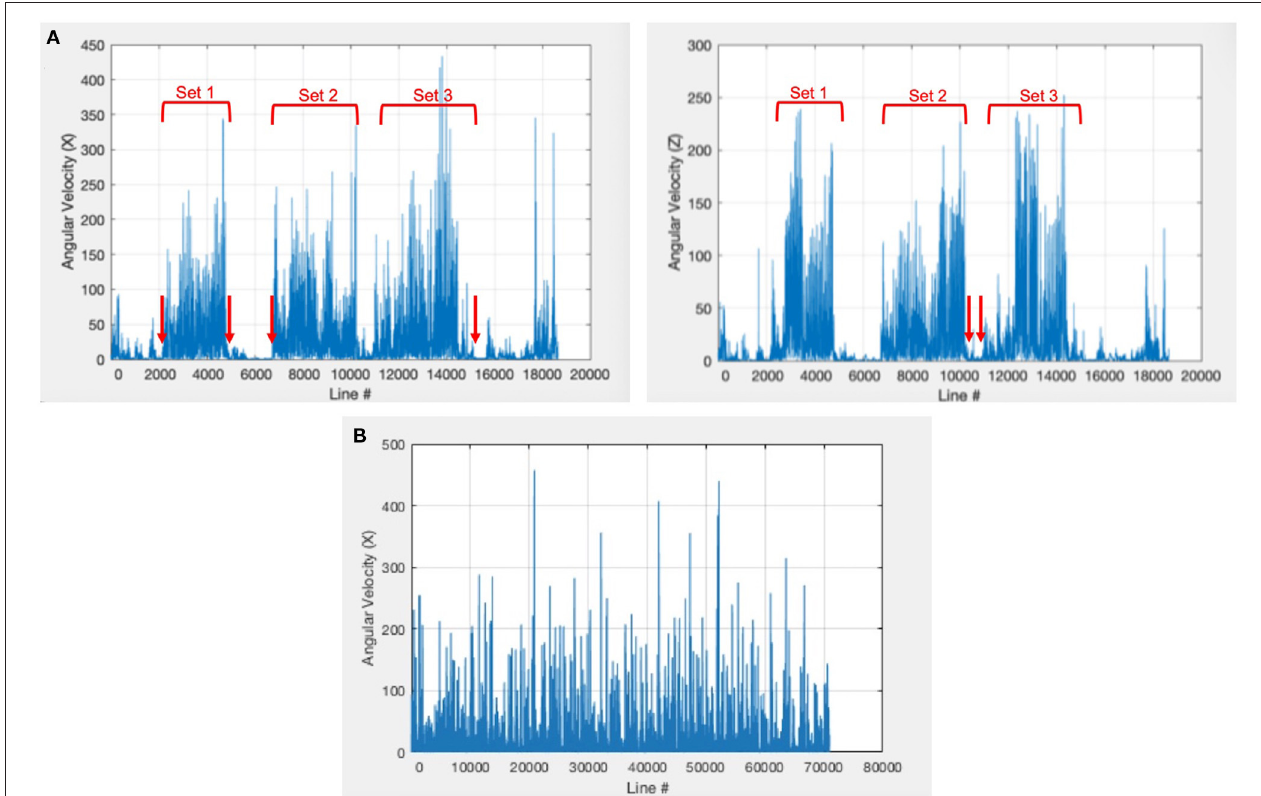
FIGURE 1 | Example Matlab ® output for determination of start and stop points. Participant 3 completed three individual exercise sets during the exercise seen in graph (A) . We were able to visually identify start and stop points for each set. Set 1 started at line 2170 and stopped at line 4809, set 2 started at 6778 and stopped at 10320, and set 3 started at 10960 and stopped at 15200. Participant 6 reported having completed three individual exercise sets during the exercise seen in graph (B) ; however, we were unable to visually identify three individual exercise sets when graphing the data in the custom Matlab ® program: (4597,